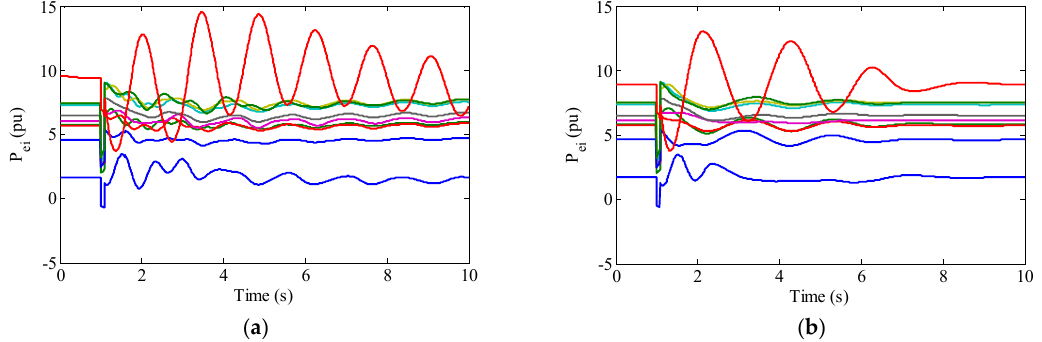
Figure 12. Electrical power response against a short circuit under operating condition 2. ( a ) Conventional PID governor controller; ( b ) Nonlinear synergetic governor controller.